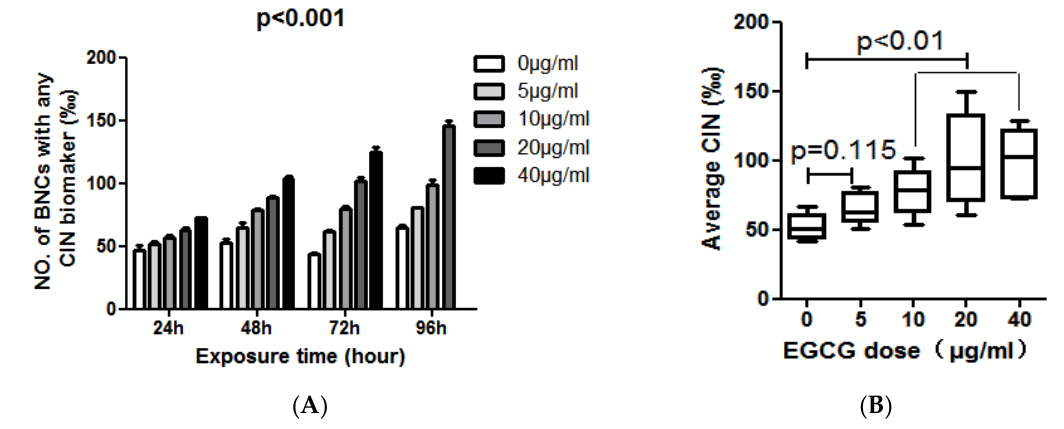
Figure 3. ( A ) The effect of EGCG dose on the frequency of BNC containing chromosomal instability (CIN) biomarkers (MN and /or NPB and/or NBUD); ( B ) The average effect of 96-h exposure to